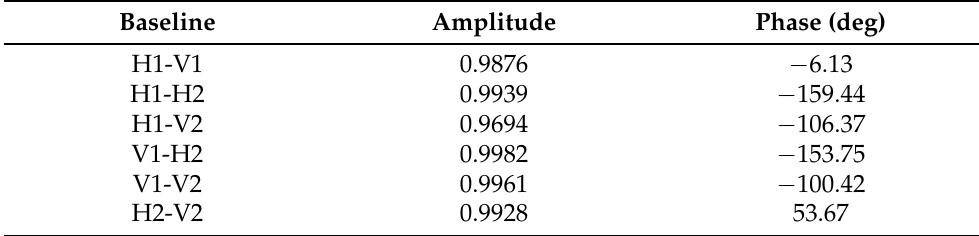
Table 2. Measured fringe washing function at the origin.